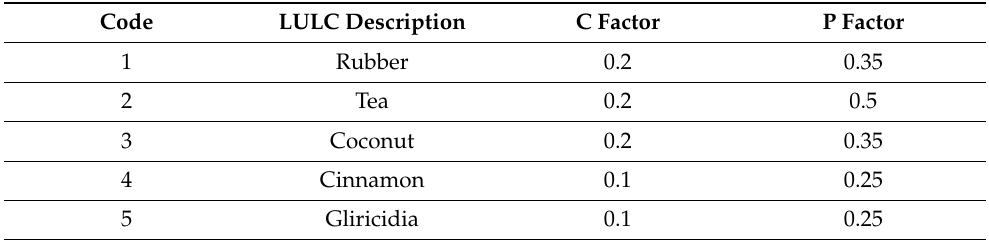
Table 1. Biophysical table with C factor and P factor values used in the model